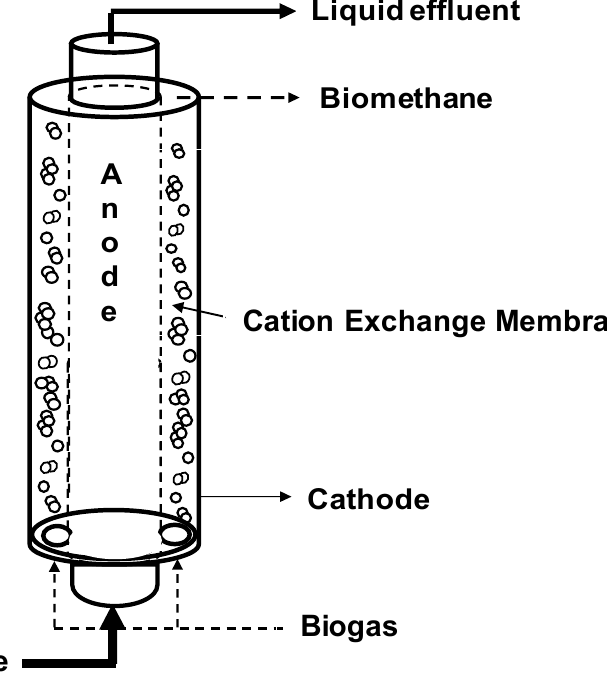
Figure 1. Scheme of the tubular microbial electrolysis cell.